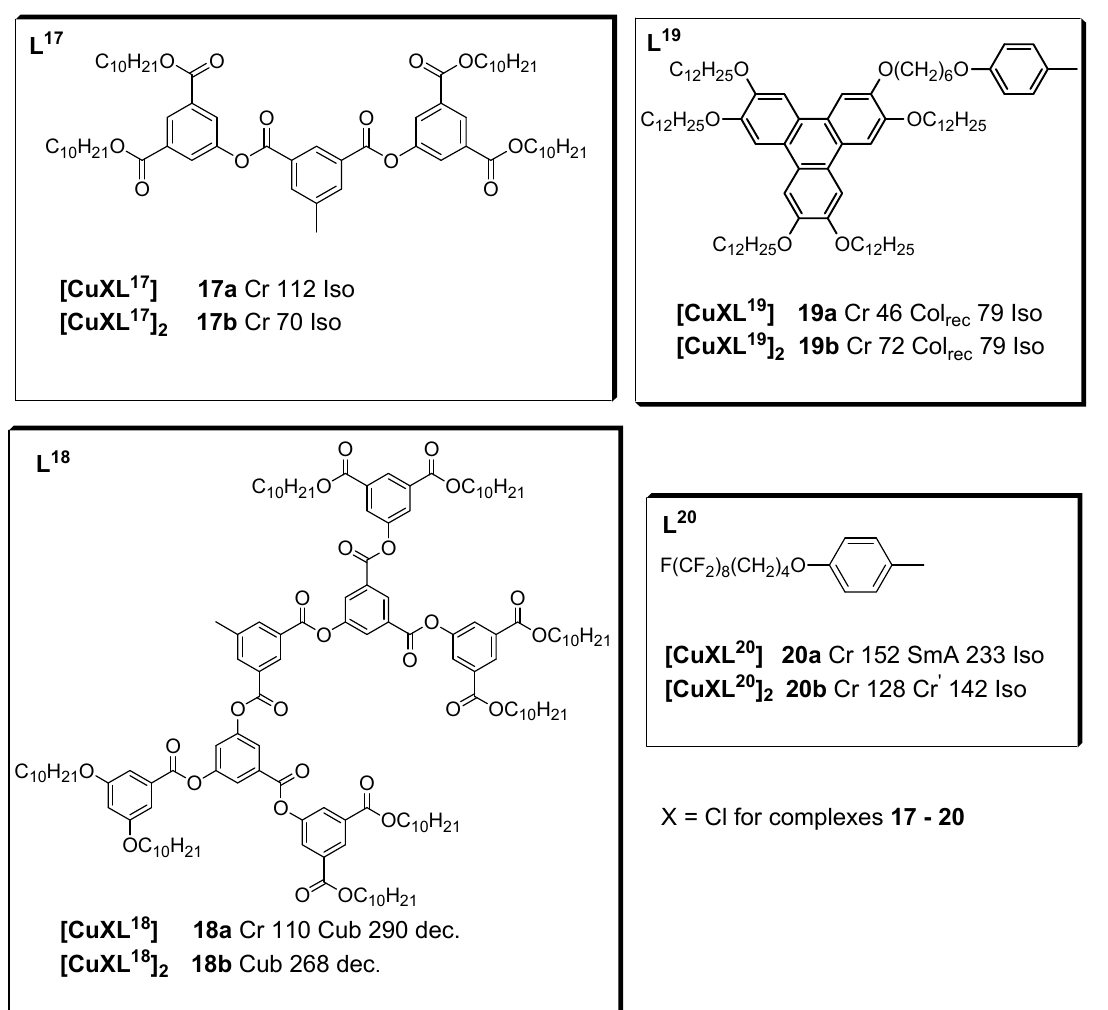
Figure 6. Mononuclear and dinuclear copper(I) isocyanide complexes. Transition temperatures are in °C [49–53].